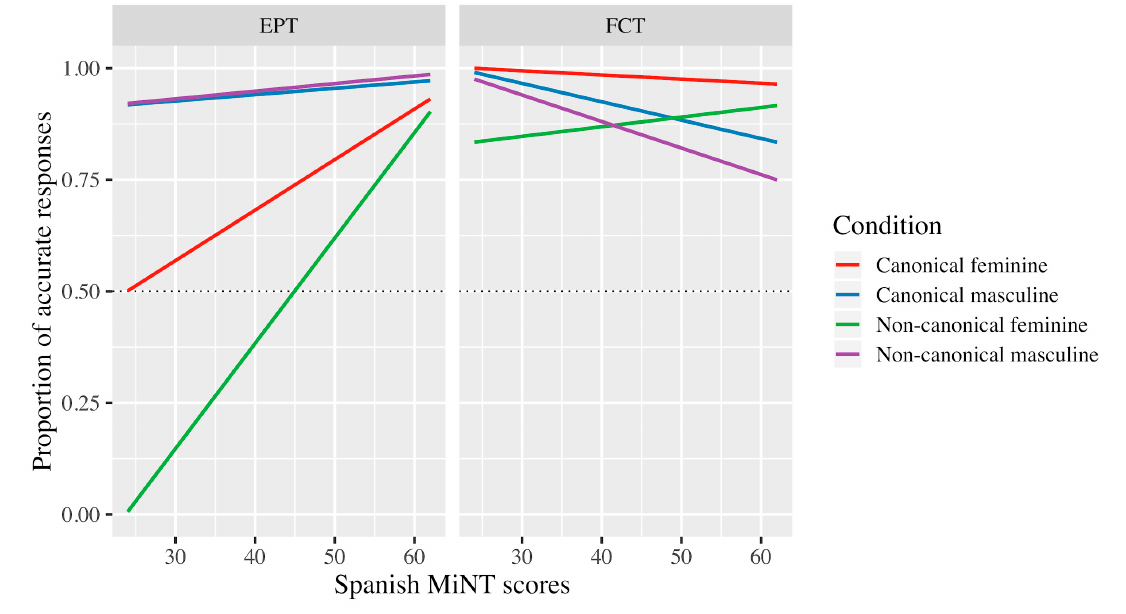
Figure 3. MiNT scores and accuracy in gender assignment and agreement.